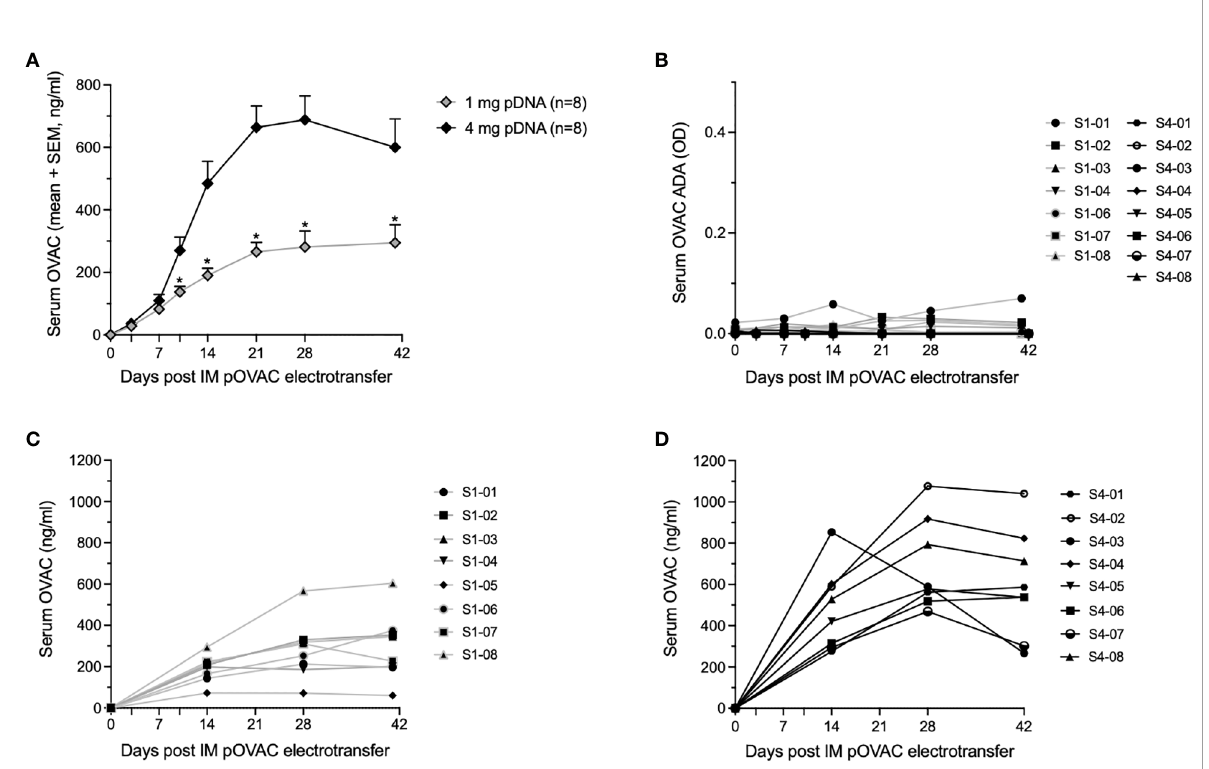
FIGURE 1 Readouts after administration of 1 or 4 mg pOVAC in sheep. (A) Mean serum OVAC concentrations following IM EP of 1 mg or 4 mg pOVAC. (B) Serum OVAC ADAs in both pDNA cohorts. Values are shown in OD at a two-fold dilution: (C, D) Individual serum OVAC levels following IM EP of 1 mg pOVAC (C) and 4 mg pOVAC (D) . EP, electroporation; IM, intramuscular.